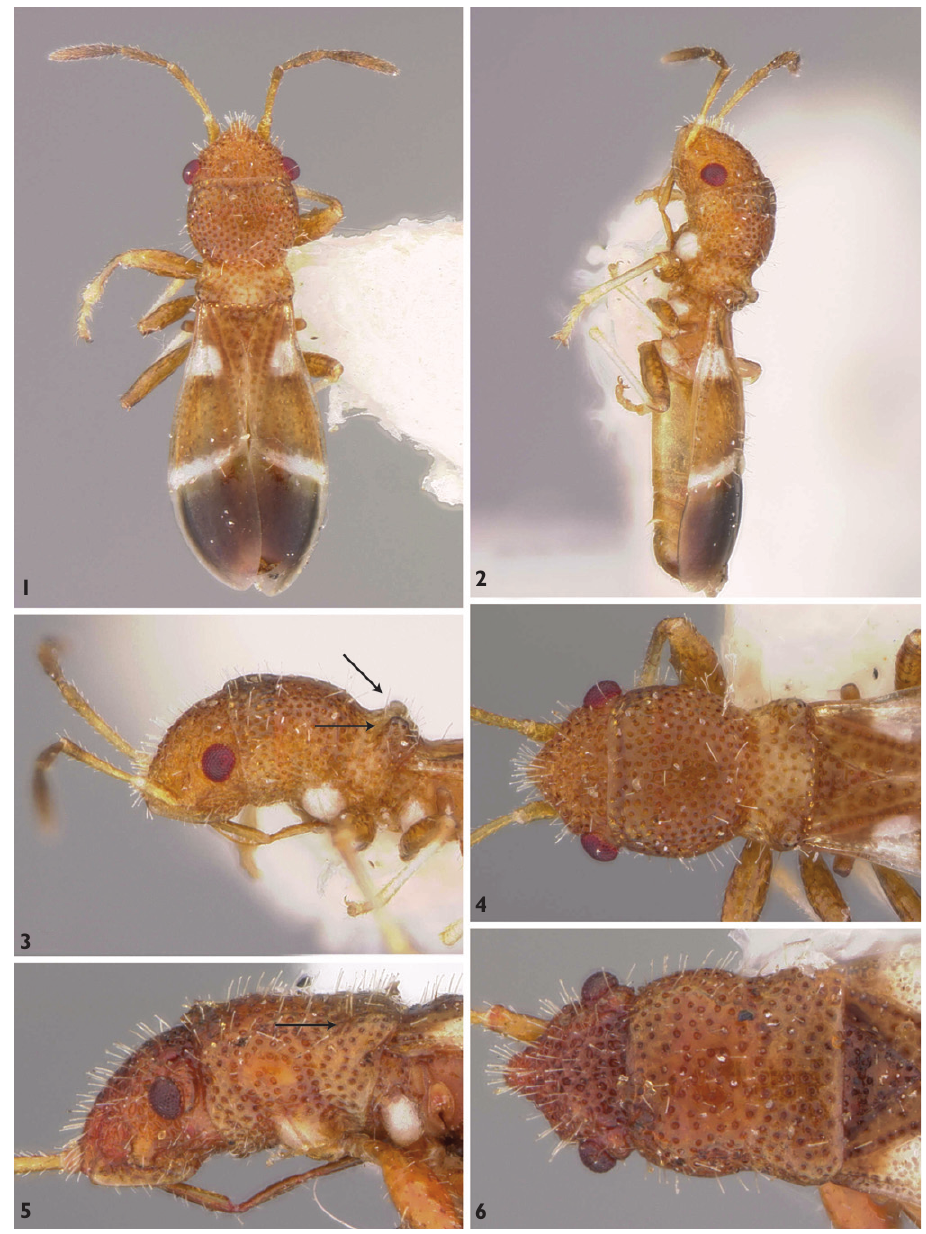
and pronotum, lateral aspect (arrows indicate position of posterolateral pronotal tubercles) 4 Head and pronotum, dorsal aspect 5, 6 Dycoderus picturatus 5 Head and pronotum, lateral aspect (arrow indicates rounded posterolateral pronotal angle lacking a distinct tubercle) 6 Head and pronotum, dorsal